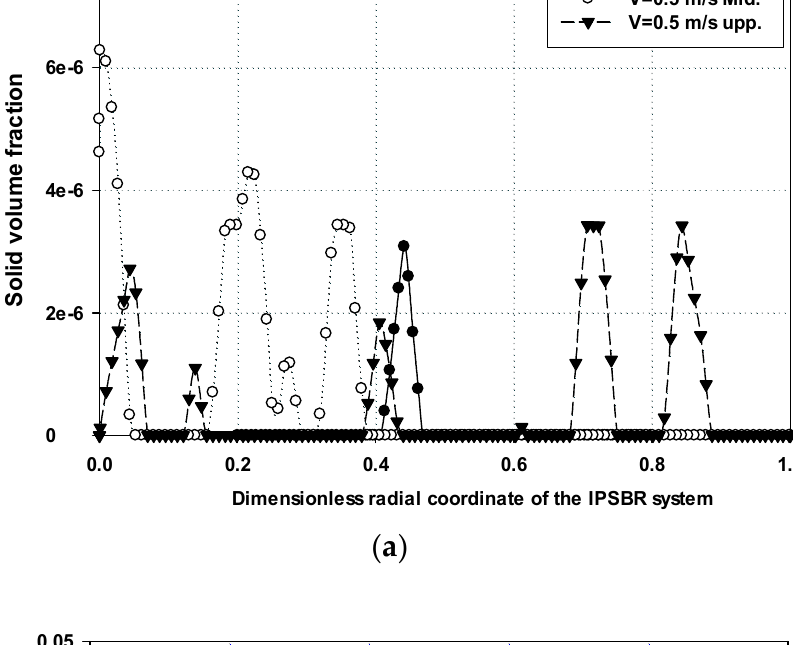
11 of 27 Figure 4. Effect of mixing particle load (( a ) 0.02 kg and ( b ) 0.06 kg) on the average solid velocity at a constant feed gas velocity of 1 m/s, orifice diameter of 0.003 m, gas head of 0.25 m, and mixing particle diameter of 0.0135 m in the conical, middle, and upper regions.